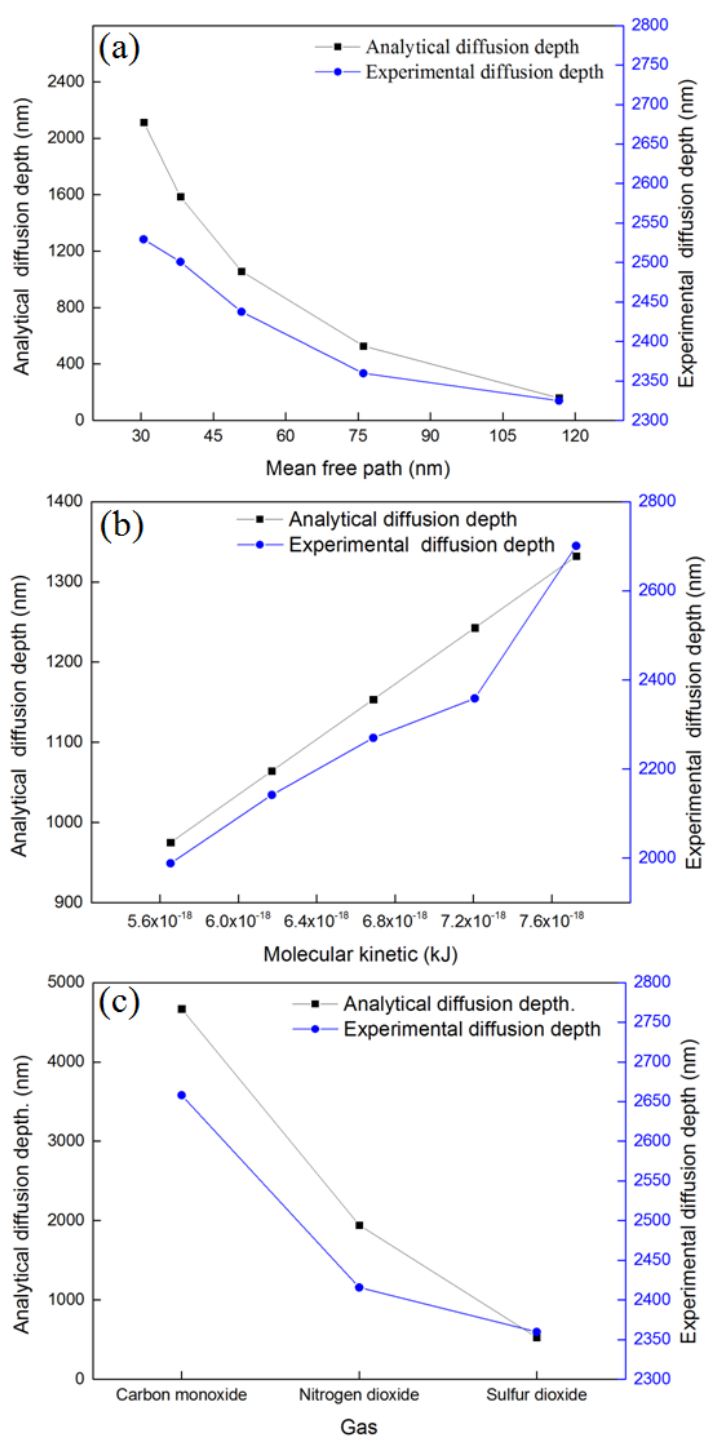
Figure 8. A comparison of diffusion depths between analytical and empirical data with different ( a ) mean free paths; ( b ) molecular kinetic energy; ( c ) molecular polarities.